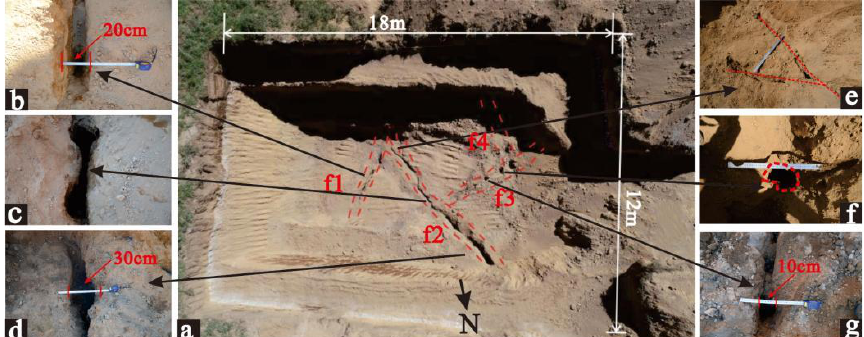
Figure 11. Bedrock cracks in Trench 2. ( a ) Top view of the exploration trench; ( b ) f1 bedrock crack in detail; ( c – e ) f2 bedrock crack in detail; ( f ) f4 bedrock crack in detail; ( g ) f3 bedrock crack in detail. Three ground fissures were exposed in Trench 3 (Figure 12). Bedrock cracks f1 and f3